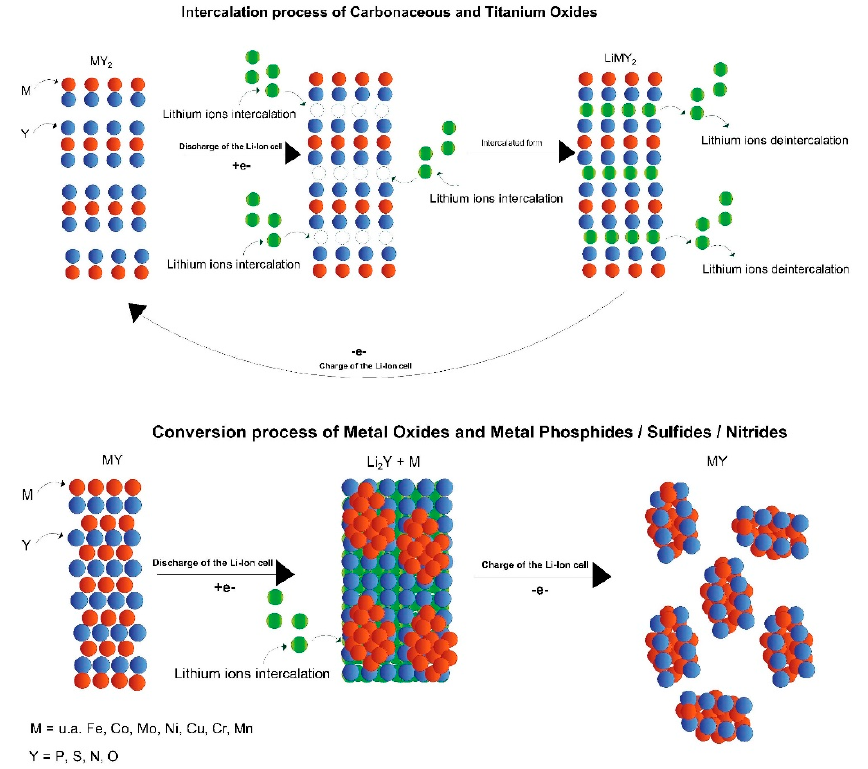
Figure 13. Nyquist plots and substitute circuit for Ti5Mo5 system before and after charge/discharge.